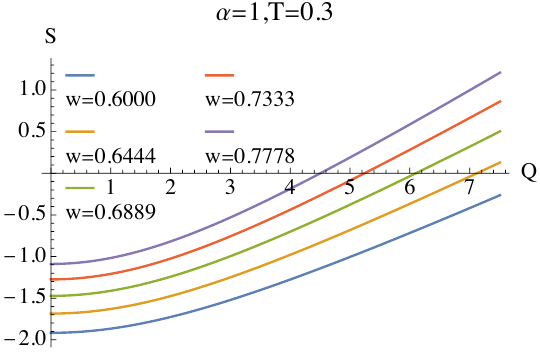
Figure 5 . HEE vs Q in different value of width w when α = 1 and T = 0 . 3 .